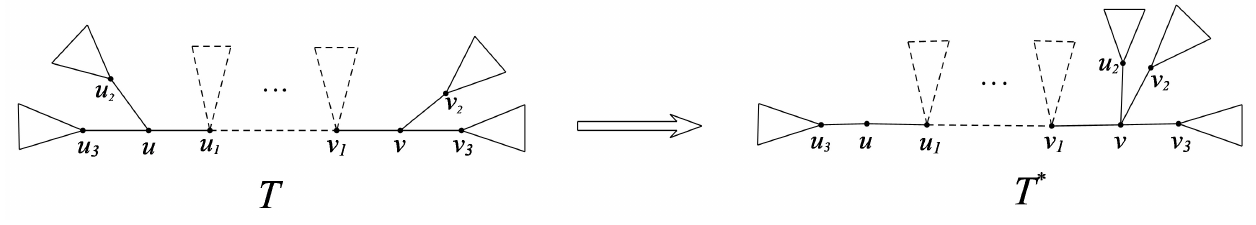
Figure 3: Transformation B used in Lemma